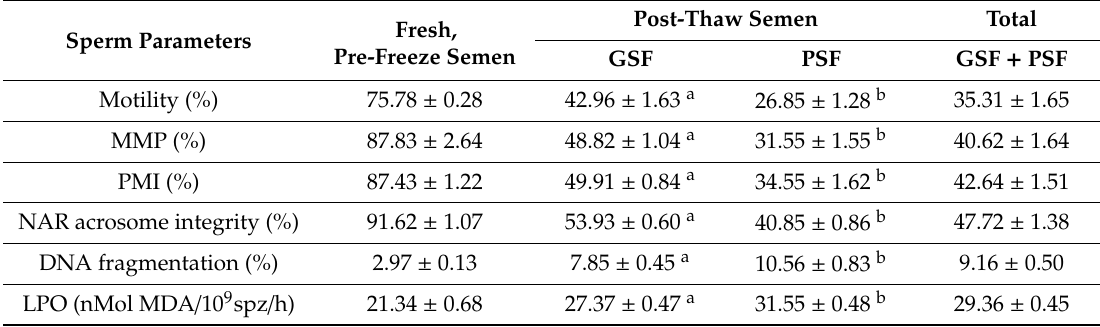
DNA fragmentation (%)